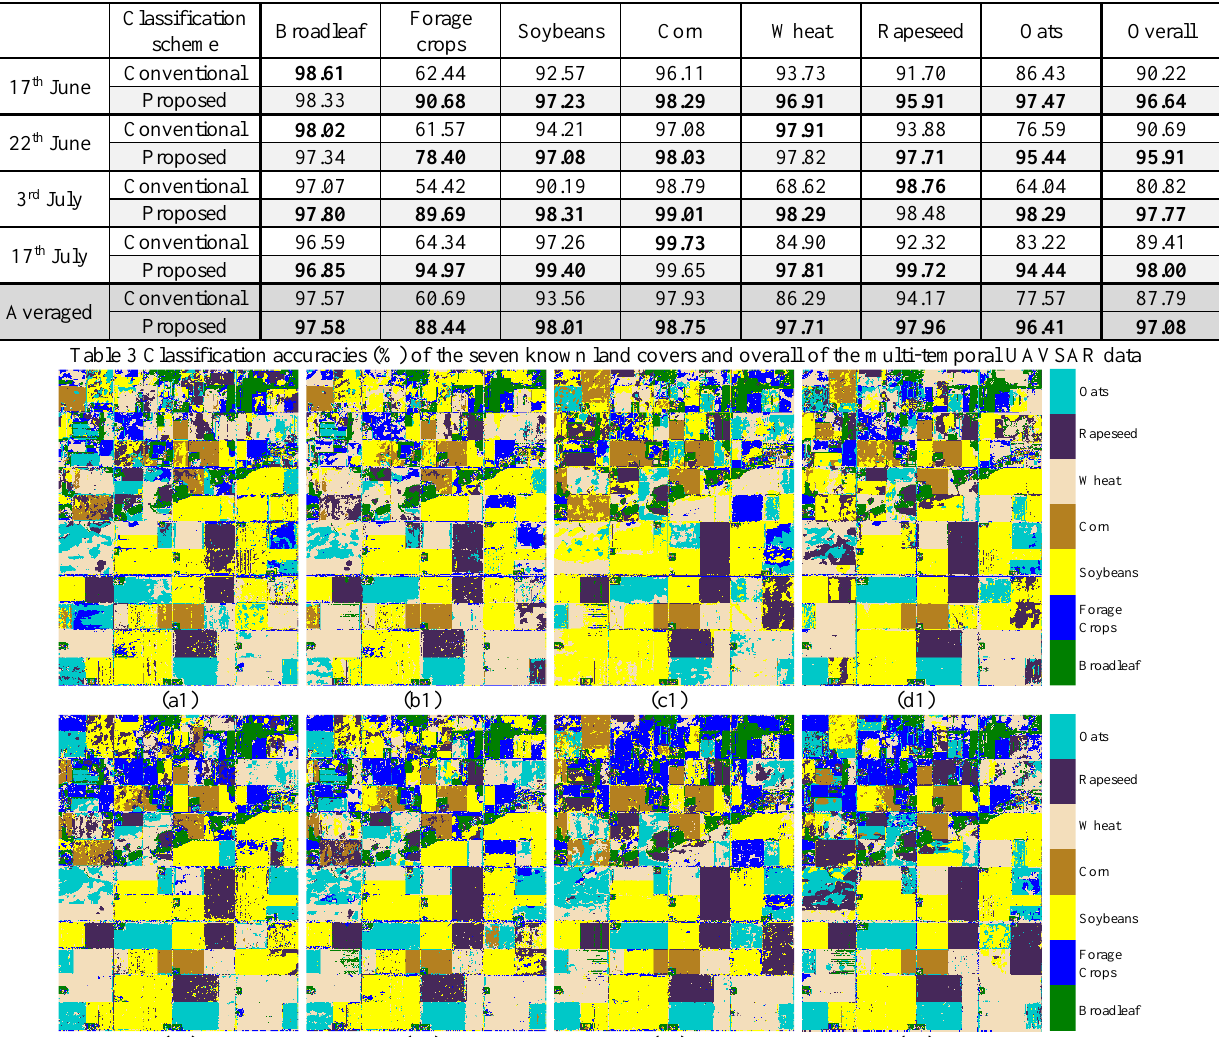
Figure 8 Classification results over the full-scene area. (a1)-(d1) are 17 th June, 22 th June, 3 rd July and 17 th July with the conventional classification scheme, (a2)-(d2) are 17 th June, 22 th June, 3 rd July and 17 th July with the proposed classification